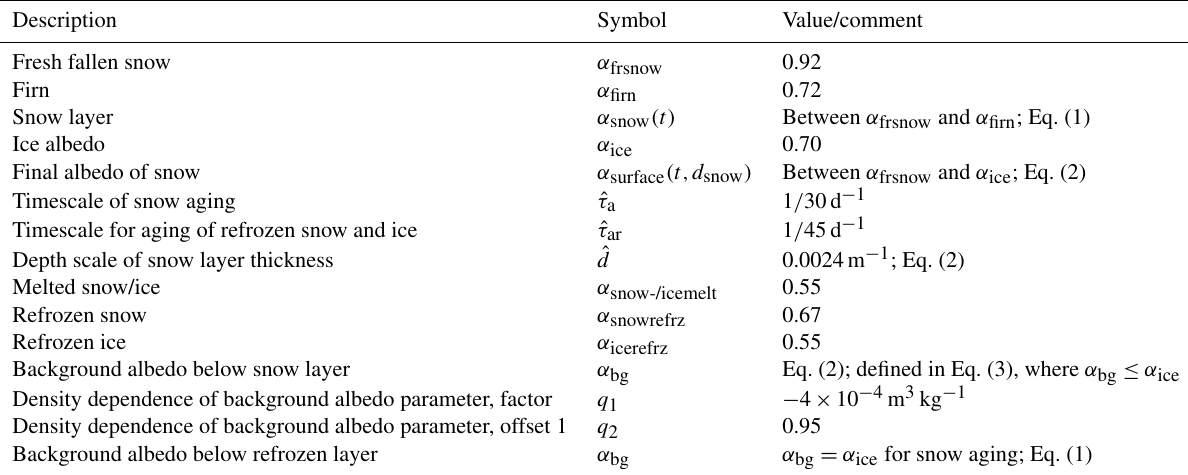
Table 1. List of constants used in the albedo scheme as part of the EBM. Please see Sect. 2.1 for further details. Description Symbol Value/comment Fresh fallen snow α frsnow 0.92 Firn α firn 0.72 Snow layer α snow (t) Between α frsnow and α firn ; Eq. (1) Ice albedo α ice 0.70 Final albedo of snow α surface (t,d snow ) Between α frsnow and α ice ; Eq. (2) Timescale of snow aging ˆ τ a 1 / 30d − 1 Timescale for aging of refrozen snow and ice ˆ τ ar 1 / 45d − 1 Depth scale of snow layer thickness ˆ d 0.0024m − 1 ; Eq. (2) Melted snow/ice α snow-/icemelt 0.55 Refrozen snow α snowrefrz 0.67 Refrozen ice α icerefrz 0.55 Background albedo below snow layer α bg Eq. (2); defined in Eq. (3), where α bg ≤ α ice Density dependence of background albedo parameter, factor q 1 Density dependence of background albedo parameter, offset 1 q 2 0.95 Background albedo below refrozen